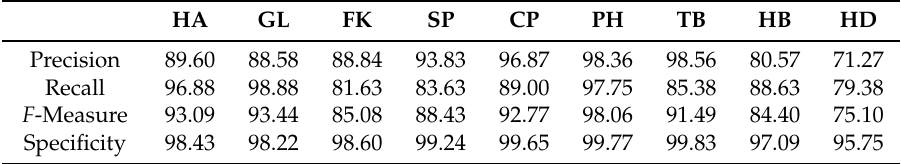
Table 4. Values of precision, recall, F-Measure, specificity of LOSO model SVM IW (all values are expressed in %). The gestures are classified as follows: HA stands for Hand, GL stands for Glass, FK stands for Fork, SP stands for Spoon, CP stands for Cup, PH stands for Phone, TB stands for Toothbrush, HB stands for Hairbrush and HD stands for Hair dryer.